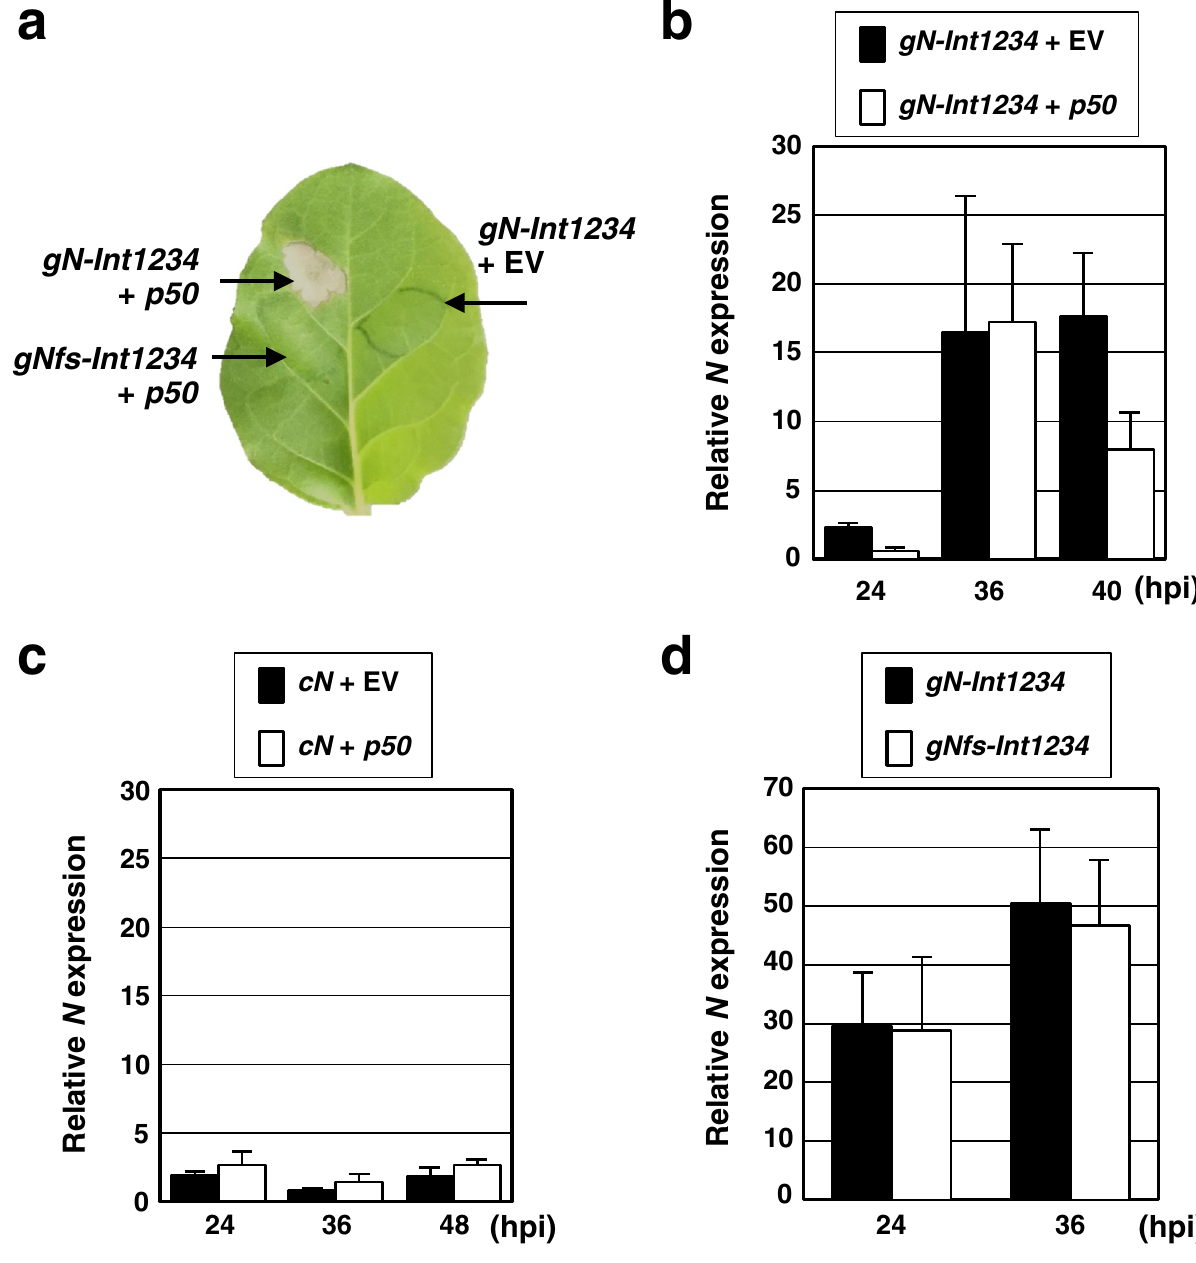
Figure 2. Intron-dependent enhanced expression of 35S-driven N in the presence or absence of elicitor, p50. ( a ) Agrobacterium transformants carrying a plasmid containing gN-Int1234 or gNfs-Int1234 were infiltrated with those carrying p50 to nn tobacco. In a control experiment for gN-Int1234 , agrobacteria carrying the empty vector (EV) were used. A photo was taken at 7 days post-infiltration. ( b , c ) Agrobacterium transformants carrying a plasmid of gN-Int1234 ( b ) or cN ( c ) were infiltrated with those carrying p50 or EV into nn tobacco. Transcript levels for gN-Int1234 and cN were analyzed by RT-qPCR using the F1 + R1 primer set at 24, 36, and 40 (for gN-Int1234 ) or 48 (for cN ) h post-infiltration (hpi). The transcript levels of gN-Int1234 + EV and cN + EV were adjusted to 1 with levels for other treatments relative to these values. ( d ) The transcript levels of gN-Int1234 and gNfs-Int1234 in the absence of elicitor expression, determined by RT-qPCR with the F1 + R1 primer set at 24 and 36 hpi, are shown. Transcript levels of actin were used for normalization of all values in ( b – d ). Values are the means ± SE of three independent biological